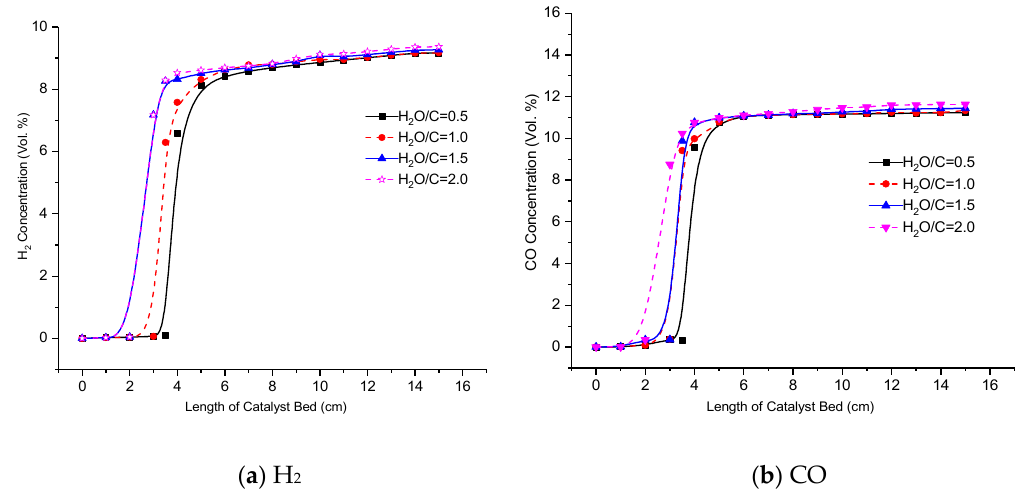
Figure 5. H 2 O / C ratio e ff ect on H 2 and CO Figure 5. H 2 O/C ratio effect on H 2 and CO concentration. Figure 5. H 2 O/C ratio effect on H 2 and CO concentration.